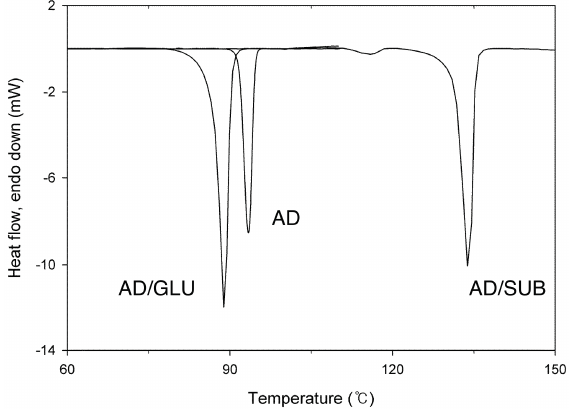
Figure 5. Differential Scanning Calorimetry (DSC) thermograms of AD and its